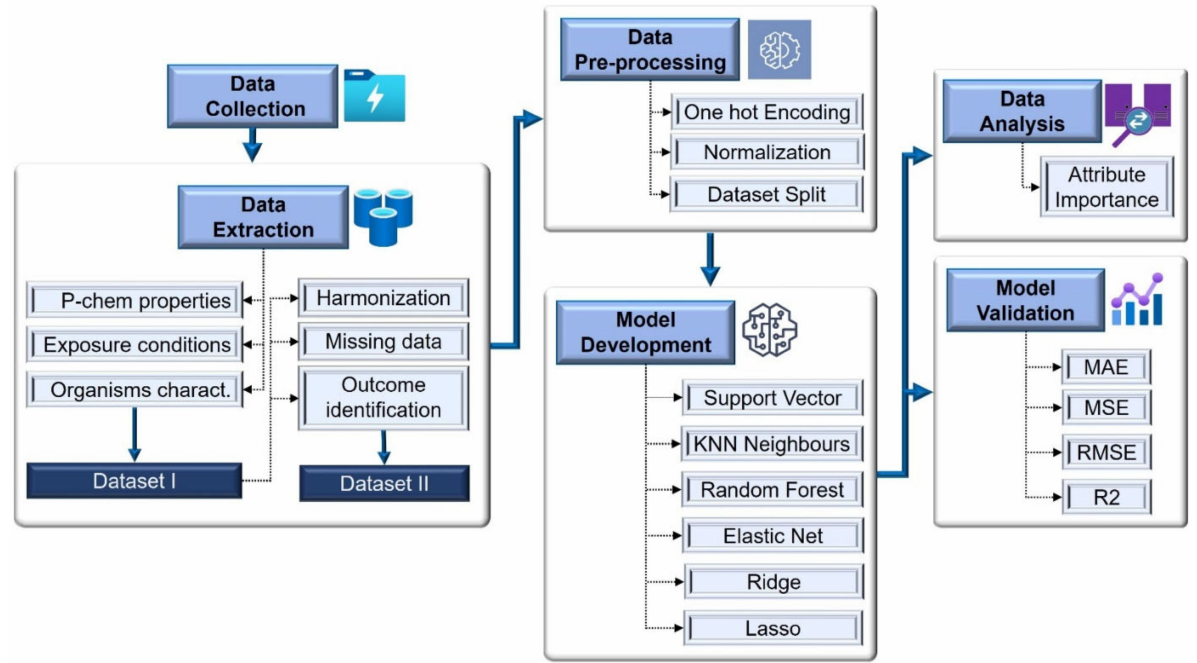
Figure 1. Model development workflow. We employed different regression models. Evaluated by mean absolute error (MAE), mean square error (MSE), root mean square error (RMSE), and coefficient of determination or R-squared